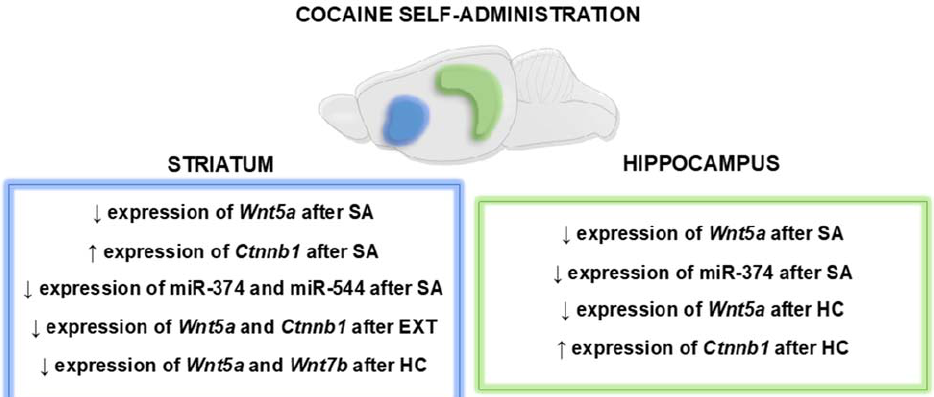
Figure 8. Summary of the significant changes in the Wnt signaling in animals exposed to intrave- nous self-administered cocaine. SA: 14 sessions of cocaine self-administration; EXT: 3 days of extinction training; HC: 3 days of home cage isolation; ↓ : decreased; ↑ : increased.